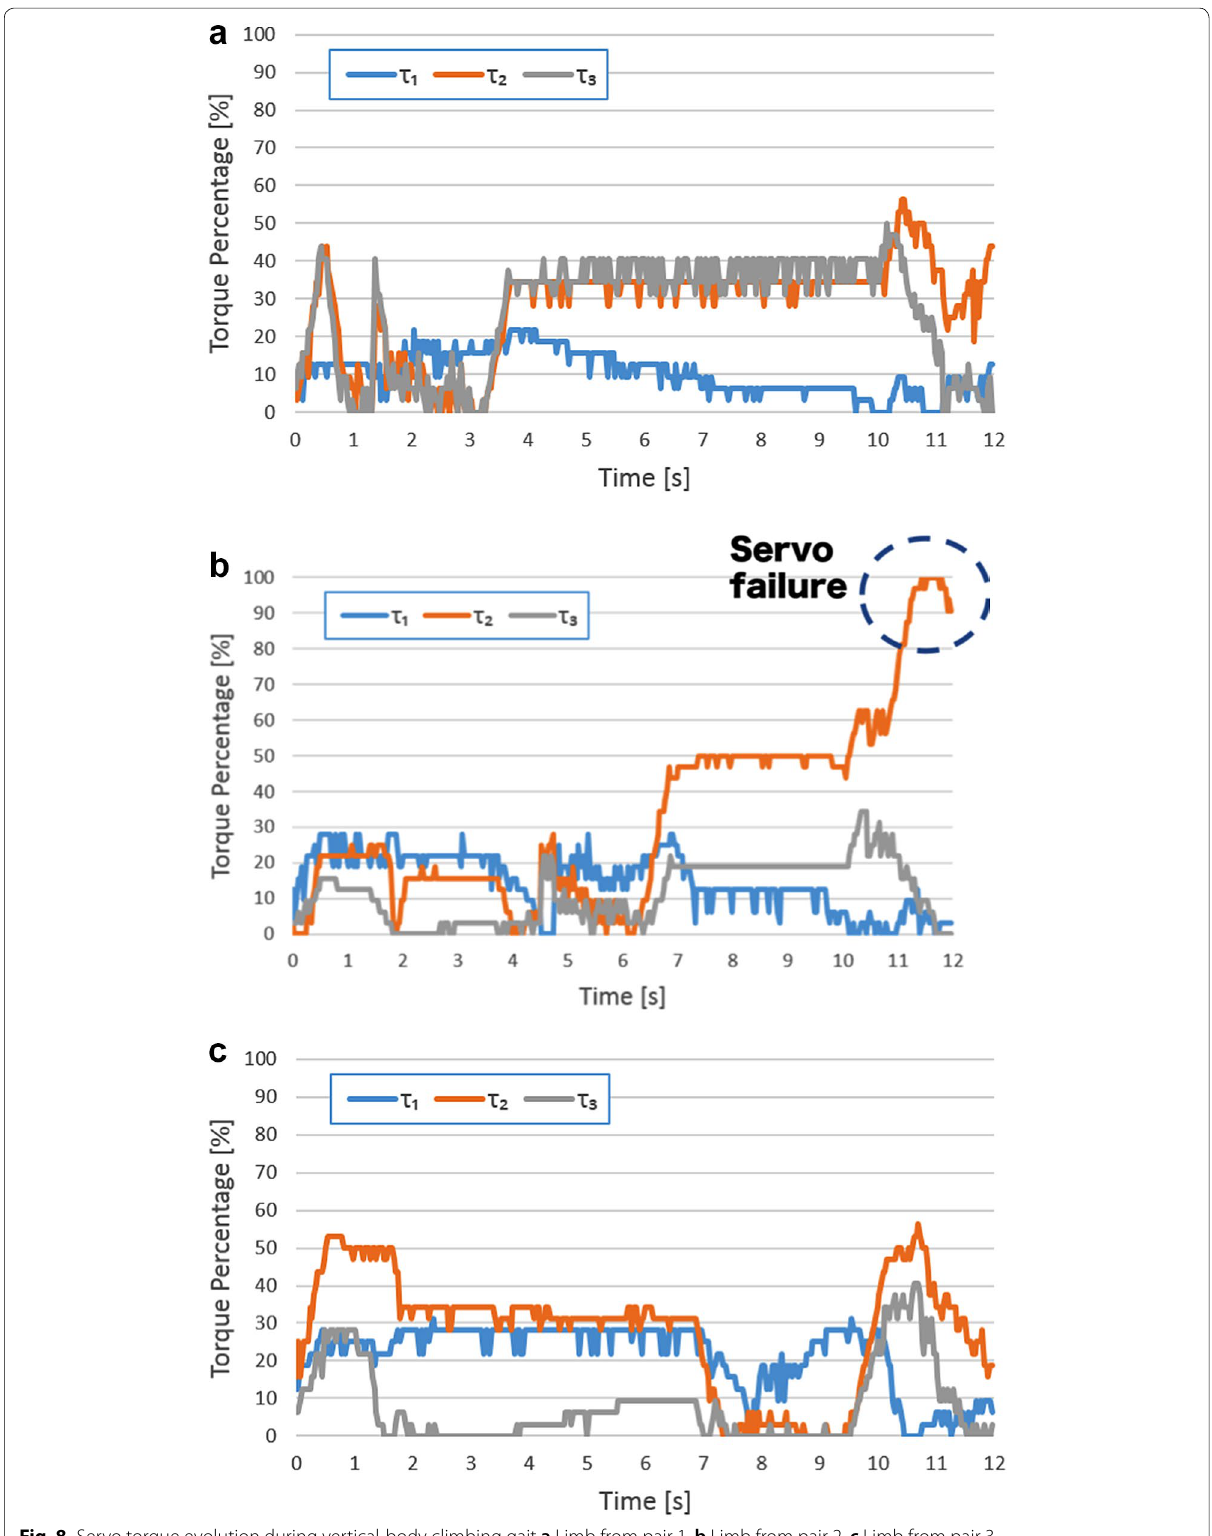
Fig. 8 Servo torque evolution during vertical-body climbing gait a Limb from pair 1, b Limb from pair 2, c Limb from pair